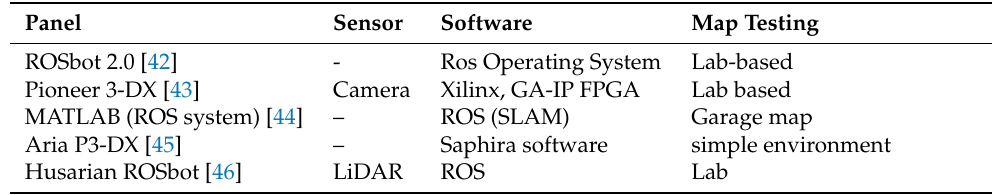
Table 1. Various parameters for